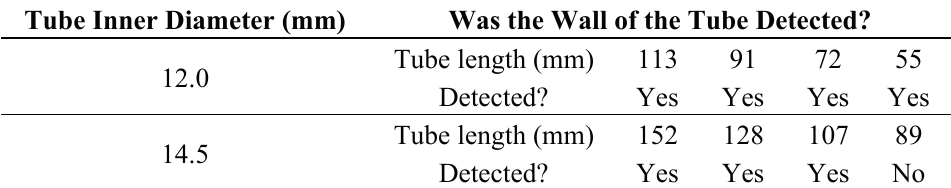
Table 1. Test to find an available size of the tube in the